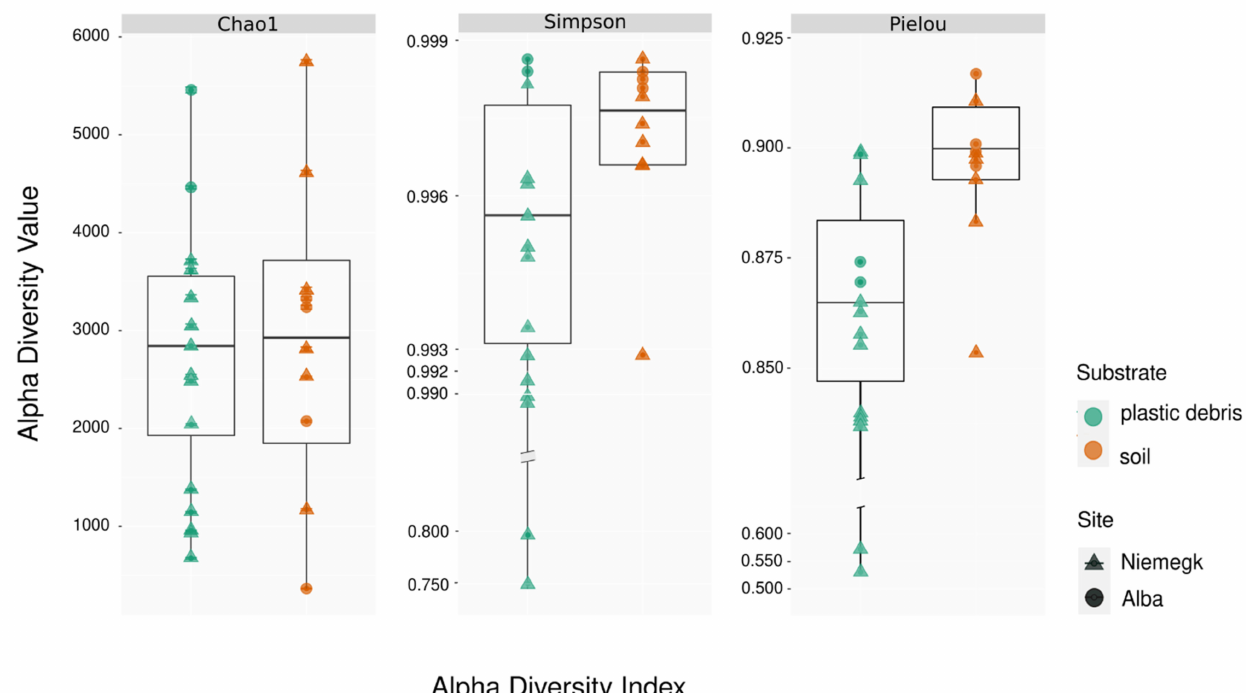
Figure 1. Microbial alpha diversity compared between plastic debris and reference soil (soil) by sampling location (site). The alpha diversity is shown as a measure of the Chao1 index of species richness, the Simpson index of dominance and Pielou’s evenness index. Points represent the calculated diversity measures of the sequenced microbial communities, whereas the boxes span the interquartile range (IQR) of all measures, with the middle line being the median of the calculated indices. A statistical summary is represented in Supplementary Table